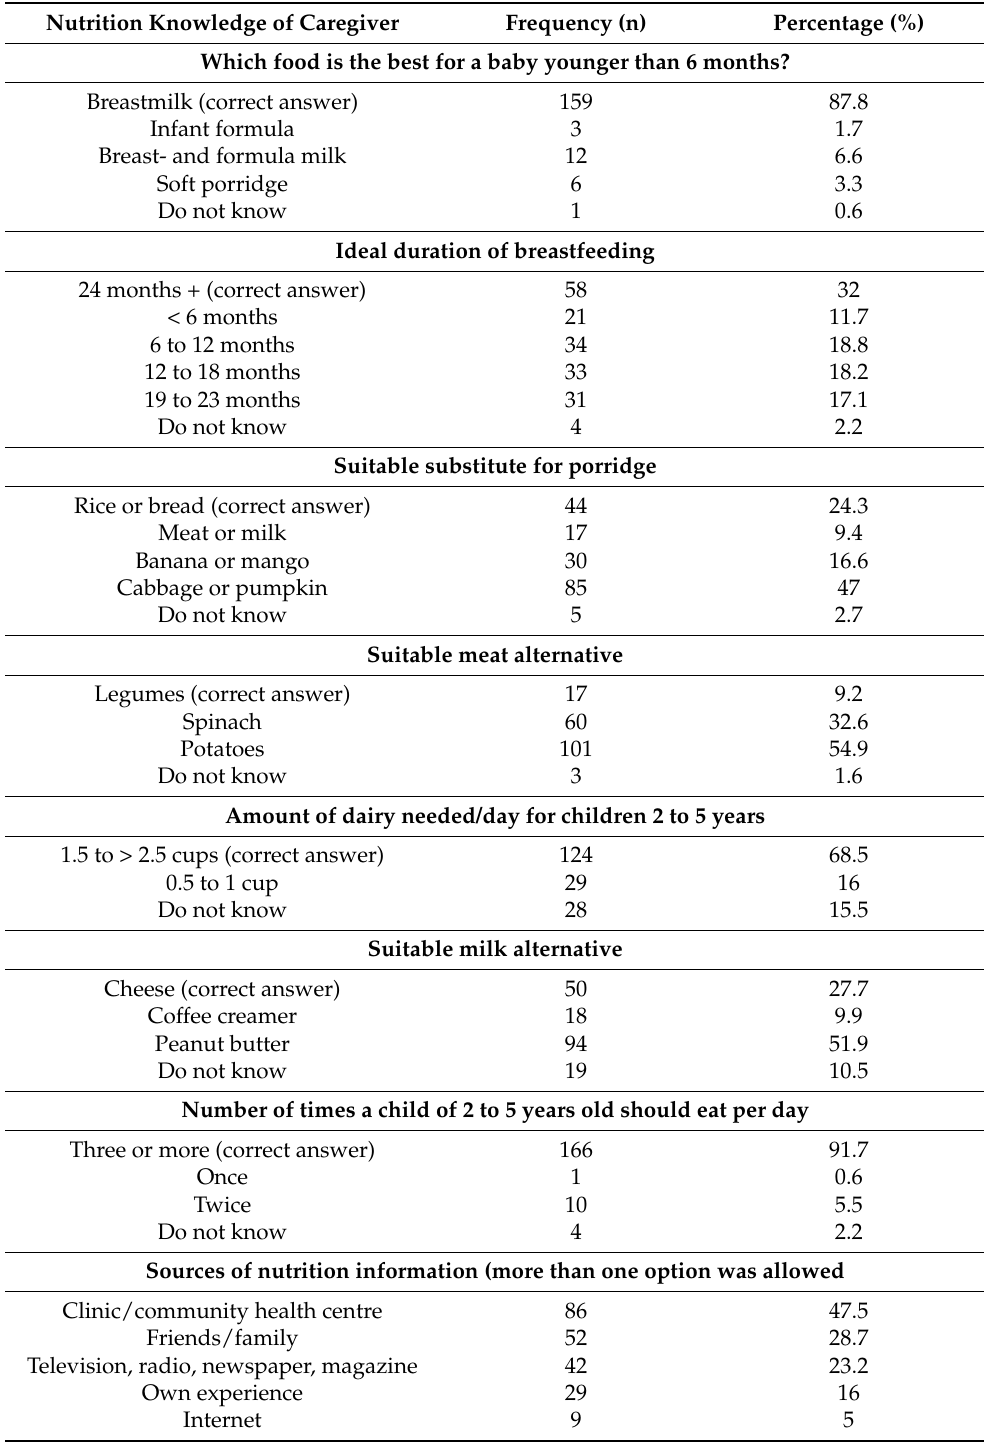
Table 3. Knowledge of caregivers regarding nutrition ( n =